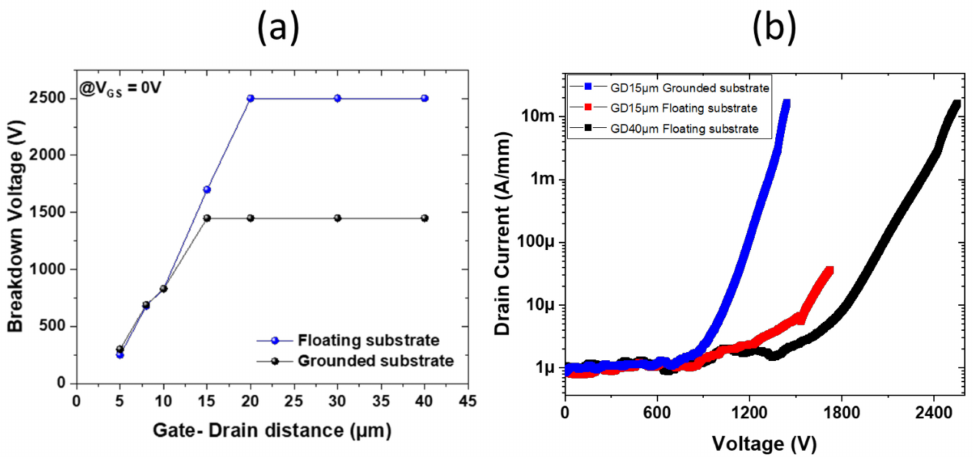
Figure 4. Transfer ( left ) and output ( right ) characteristics of a p-GaN/AlGaN/GaN HEMT with a gate–drain distance of 8 µ m at V DS = 4 V plotted in semi-log and linear scale.